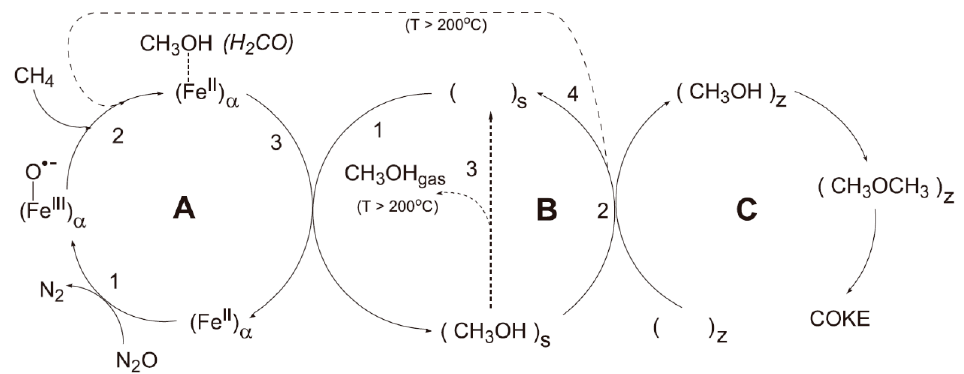
Figure 7. Mechanistic scheme of quasi ‐ catalytic and catalytic oxidation of CH 4 by N 2 O. Reprinted with permission from [57]. Copyright 2014